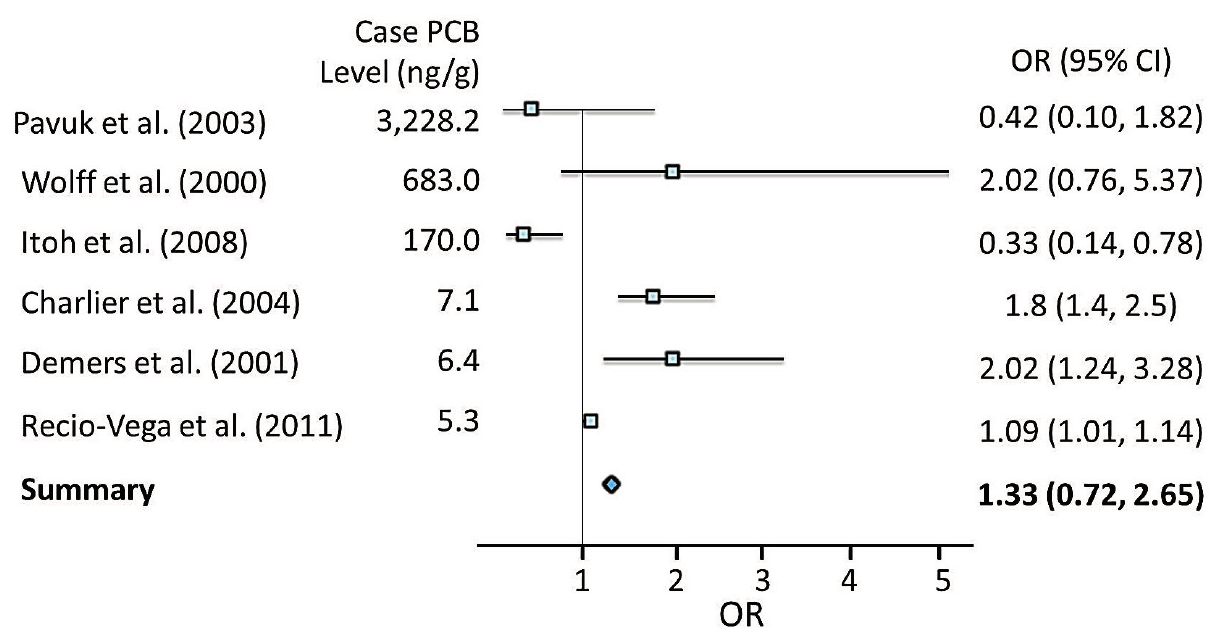
Figure 2. Forest plot of Epidemiological studies of the association between exposure to PCBs and risk of breast